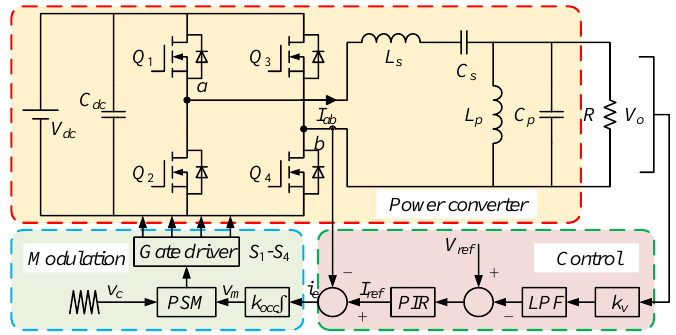
Figure 7. Control schematic of whole LCLC resonant inverter system.